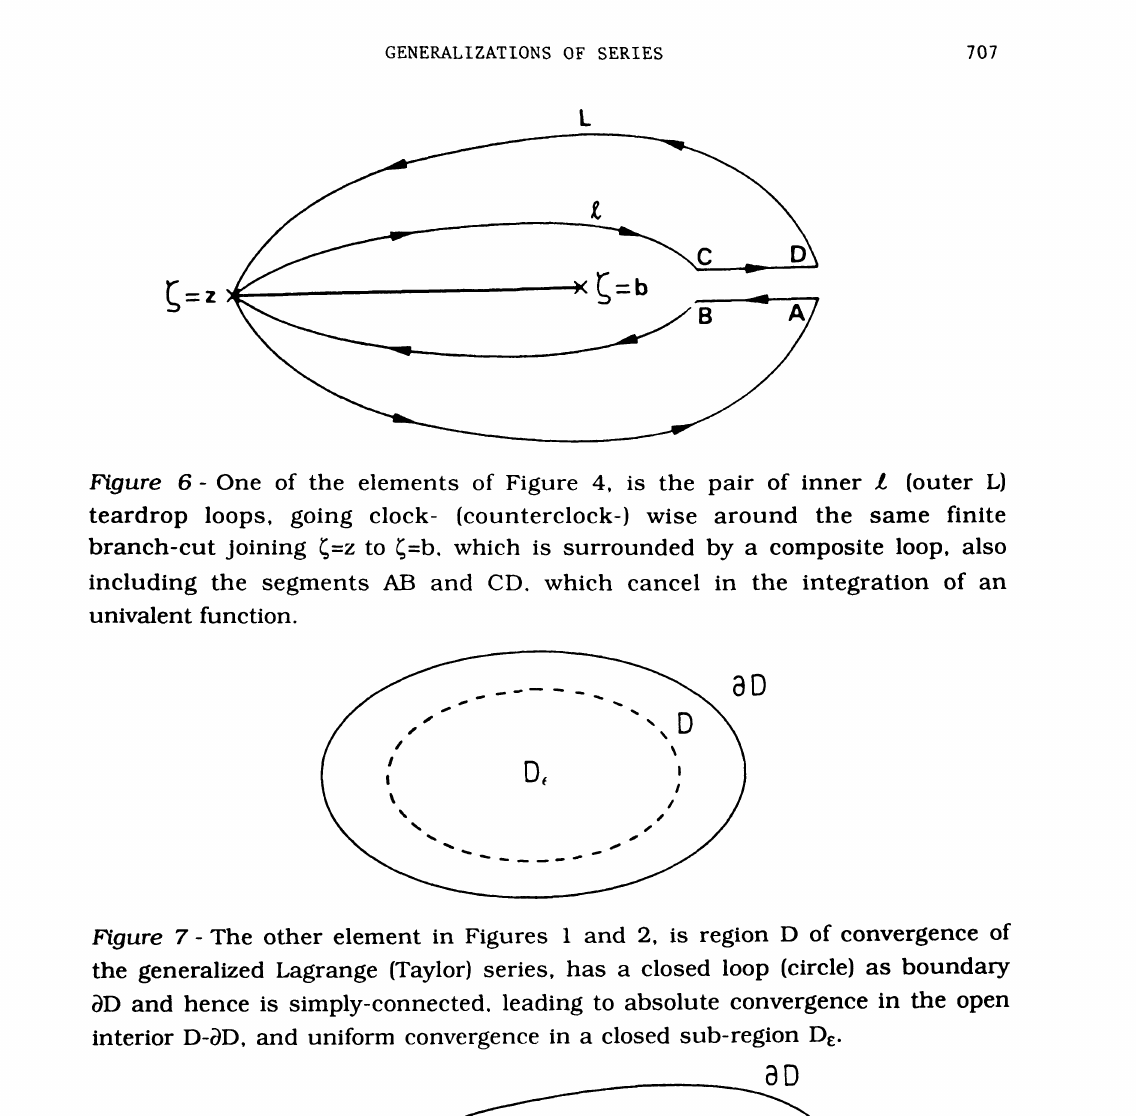
(annulus) ure 8- The second element in Figures :3 and 4, is the ring-shaped closed D of convergence of the generalized Teixeira ILaurent) series, which has DE and outer OD boundaries, non-Intersecting loops (concentric crcles) as inner convergence |n the open and hence is doubly-connected, leading to absolute convergence in a closed sub-region Interior D-OD-OE, and uniform